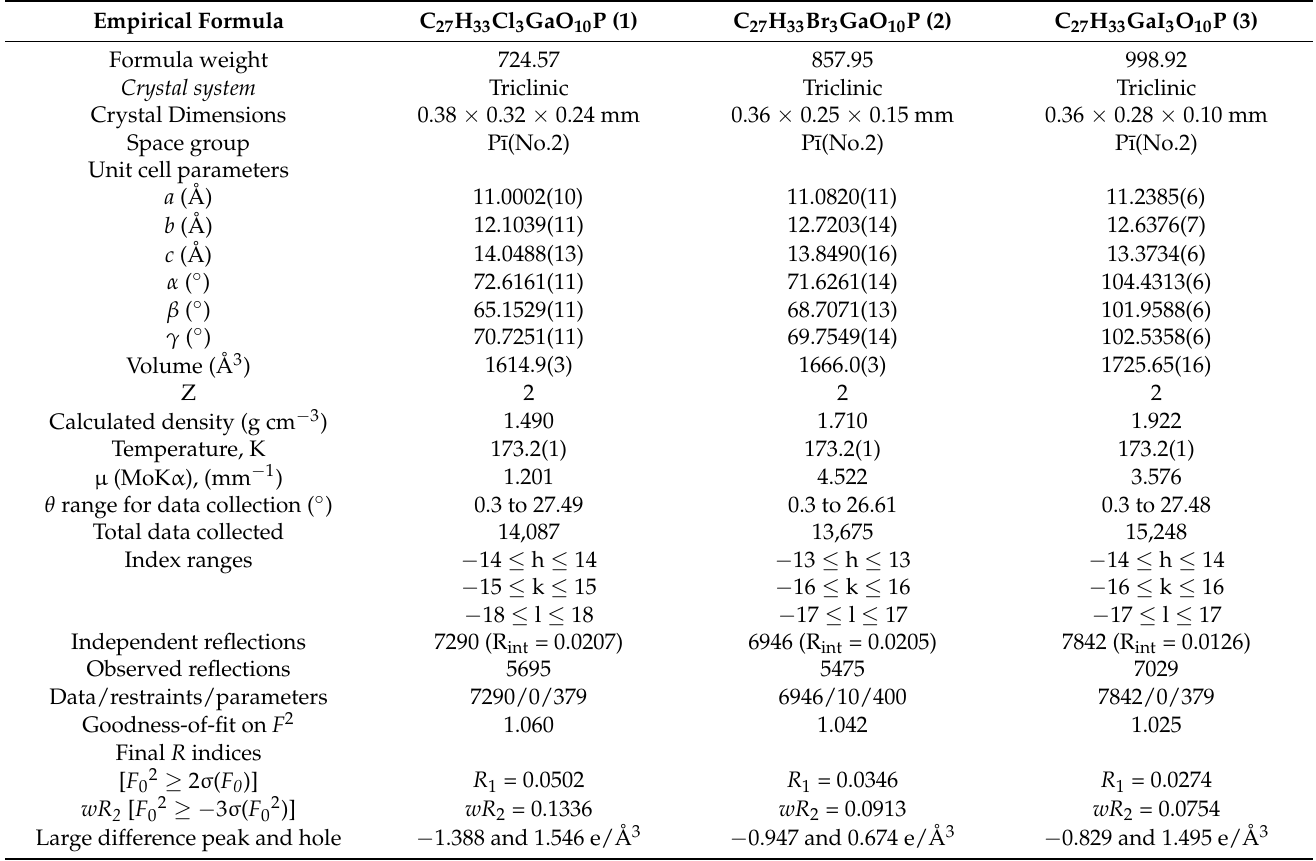
Table 1. Crystal data and structure refinement details for complexes 1 – 3